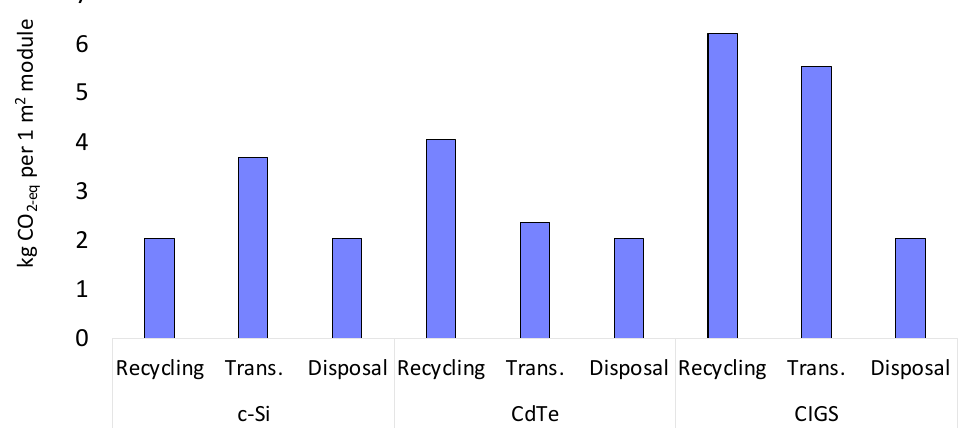
Figure 3. Carbon footprint of PV end-of-life (EoL) management.